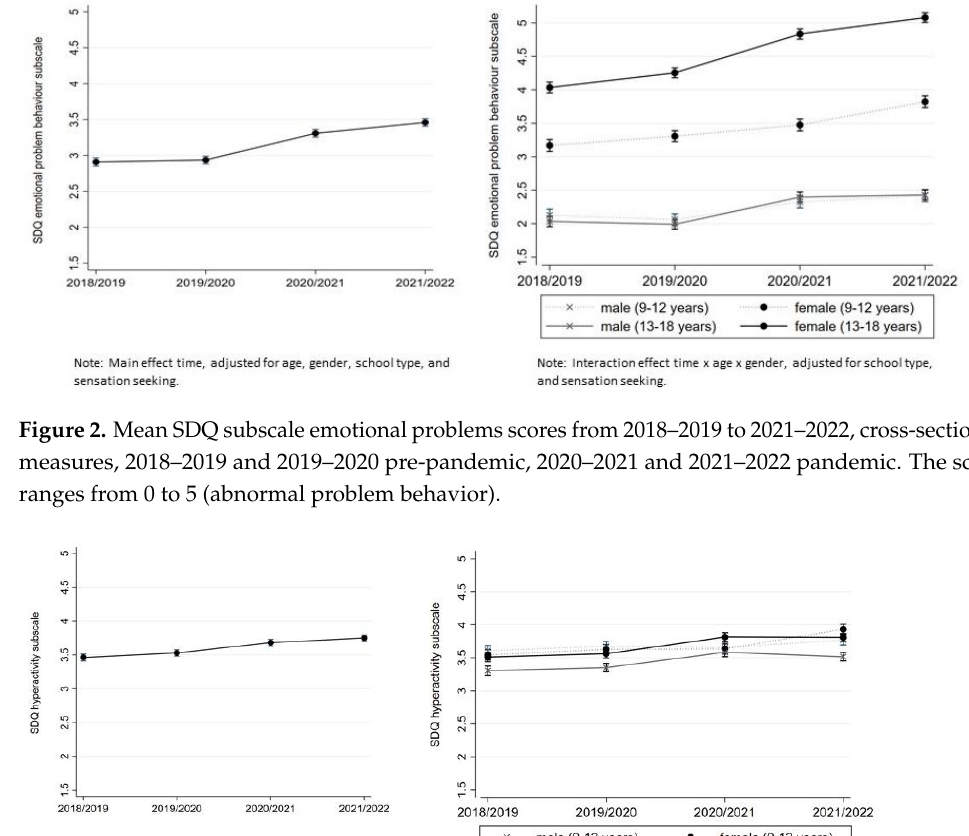
Figure 3. Mean SDQ subscale hyperactivity-inattention scores from 2018–2019 to 2021–2022, cross- The scale ranges from 0 to 10 (abnormal problem behavior).